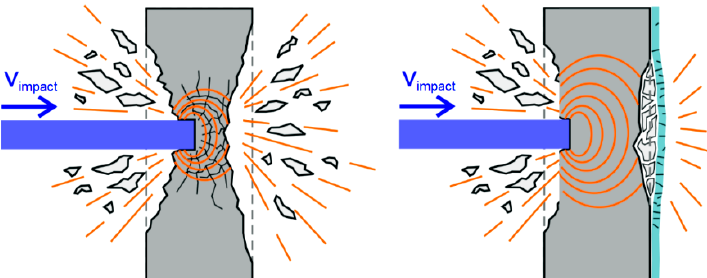
Figure 1. Behavior of an unprotected RC component ( left ) and of a strengthened concrete element ( right ) under impact; original graphic: by M. Butler (see Curosu et al. [14]), modified by M. Hering.